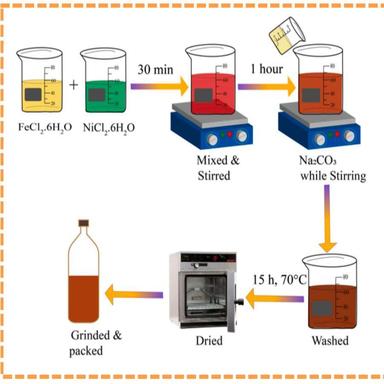
Synthesis of pristine NiFe layered double hydroxide via co-precipitation route.